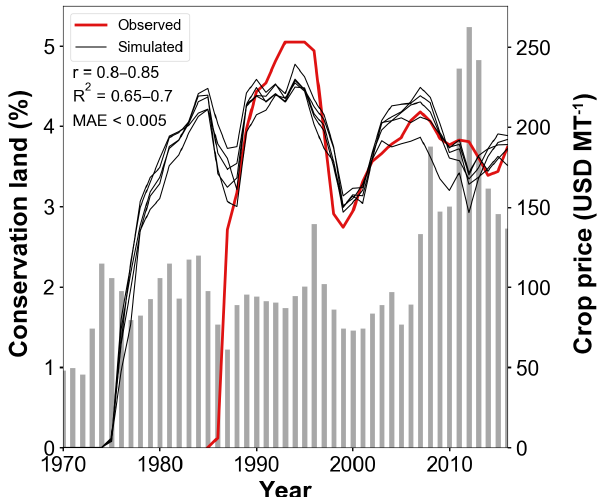
Figure 6. Simulated conservation land from four model simulations with Pearson’s r > 0 . 8 and MAE < 12.5% compared with observed conservation